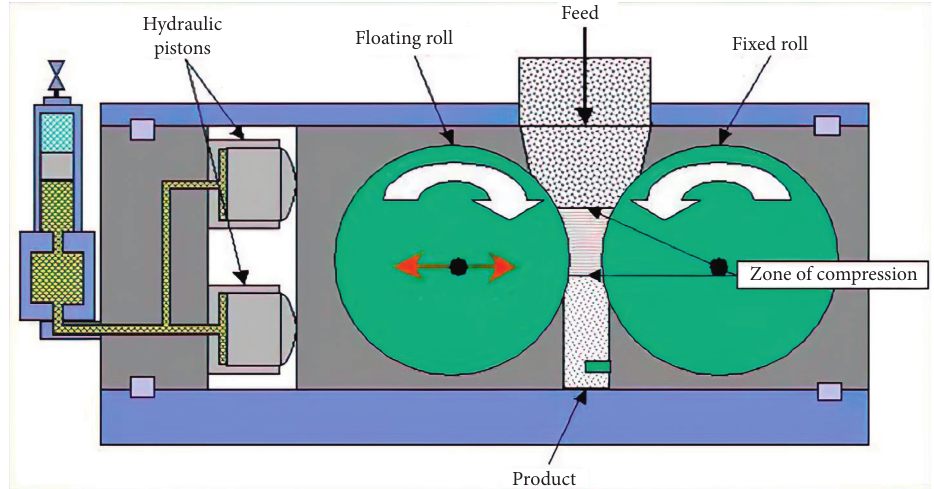
Figure 6: High-pressure grinding roll (KHD Humboldt Wedag, 2011).